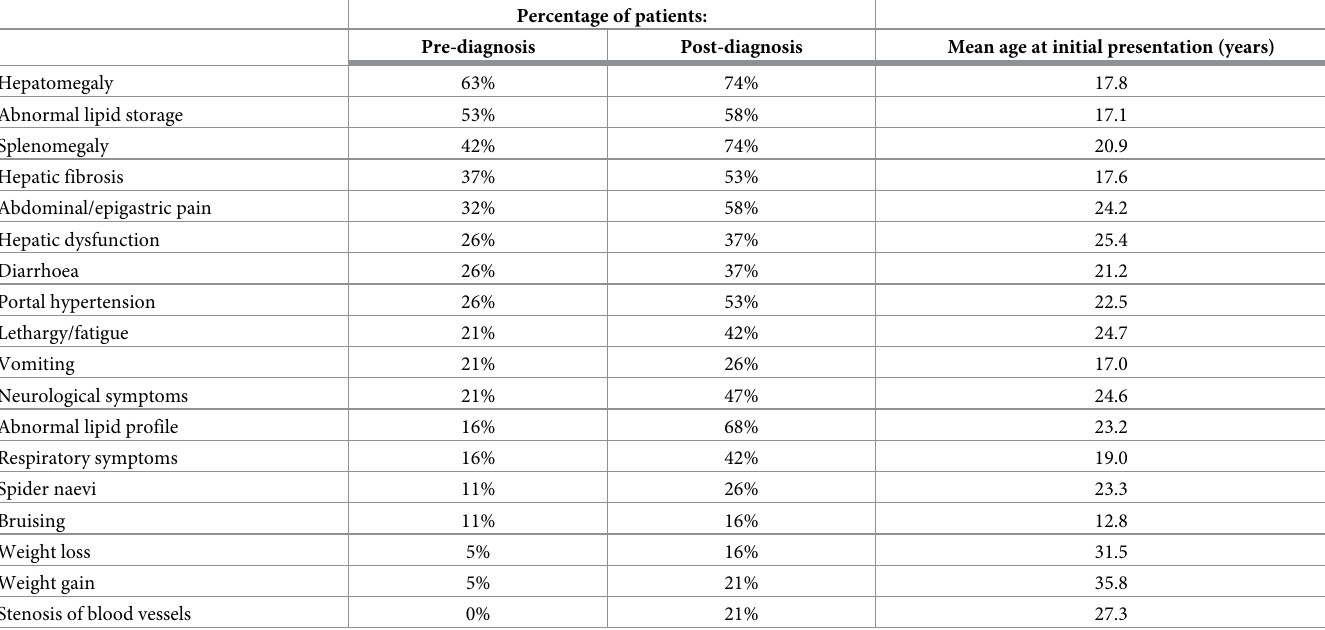
Table 3. Patients’ disease-related signs, symptoms and features.